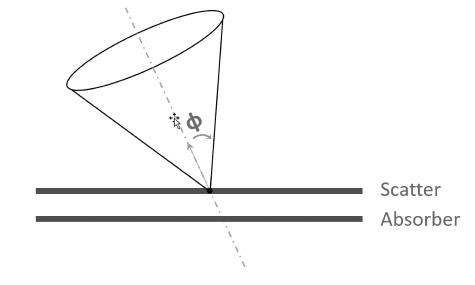
Fig. 2. The Compton camera.